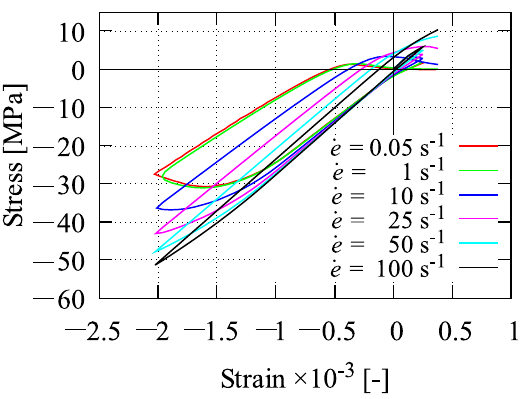
Figure 13. Homogeneous test at cyclic loading with different strain